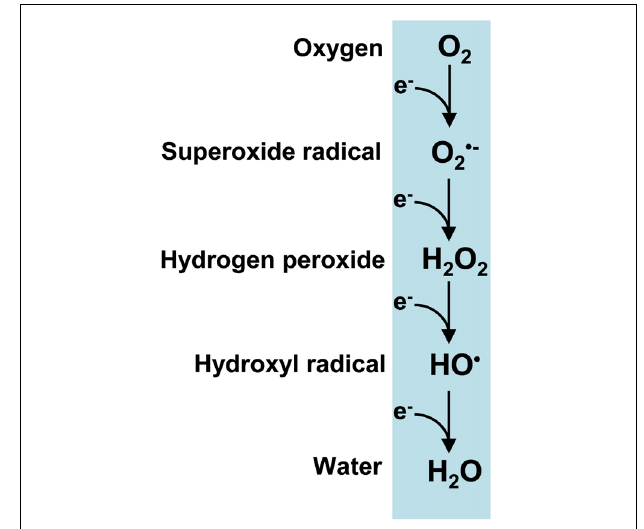
FIGURE 1 | Reactive oxygen species (ROS) produced from a sequential one-electron reduction from